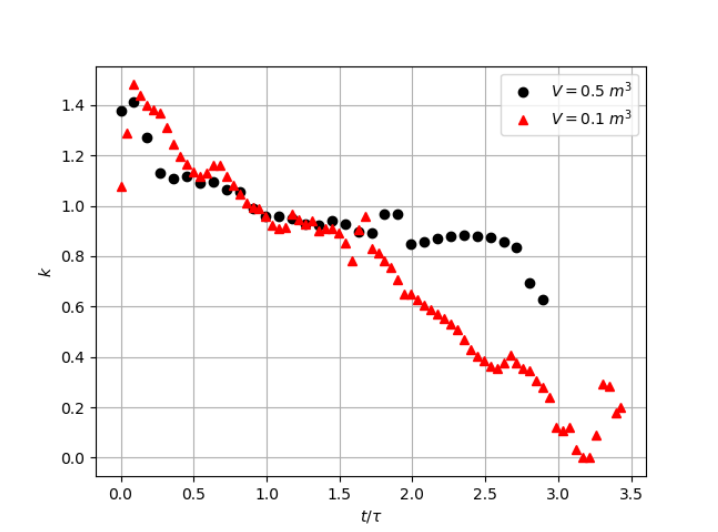
Figure 8. Different values of k , versus